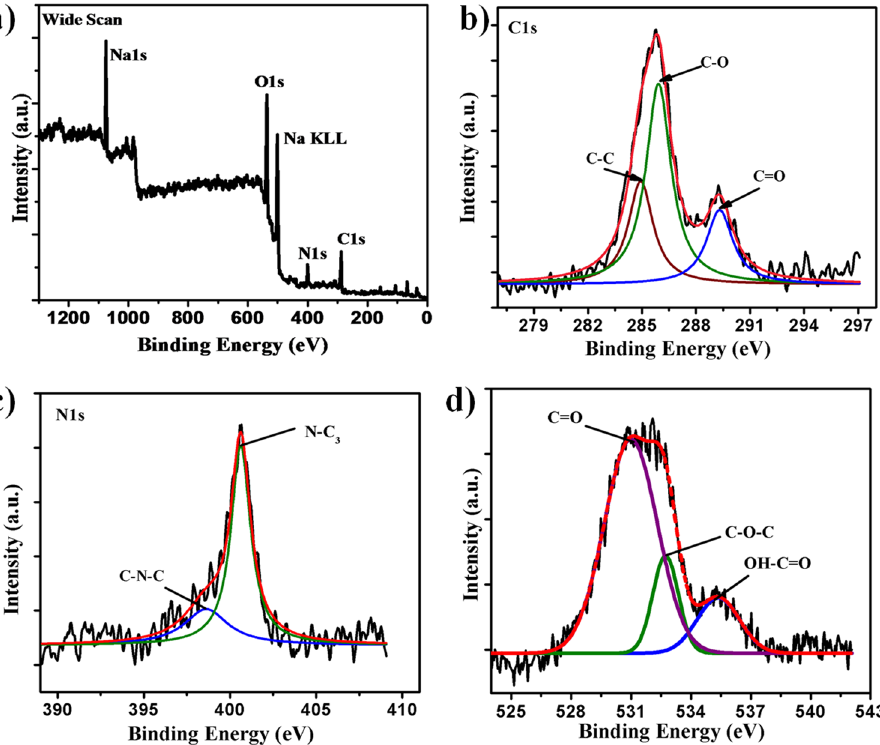
Figure 2. XPS analysis of CDs ( a ) Survey scan; High resolution spectrum of ( b ) Carbon C1s, ( c ) Nitrogen N1s and ( d ) Oxygen